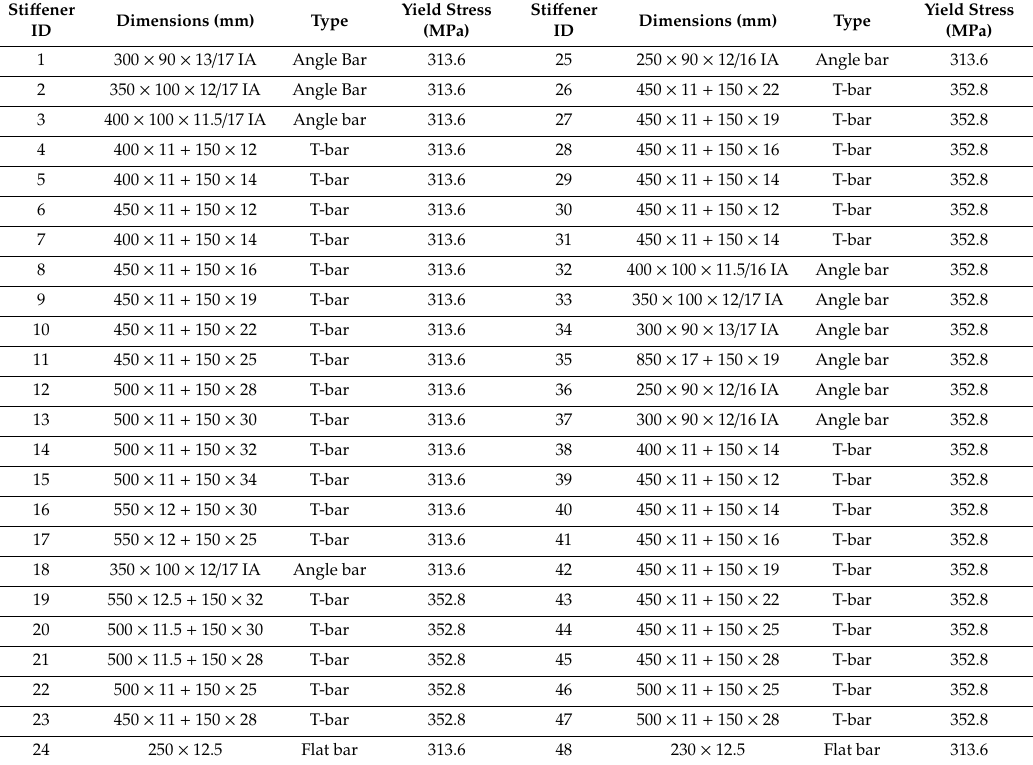
Table 2. The sti ff eners and dimensions of the double hull VLCC [25].